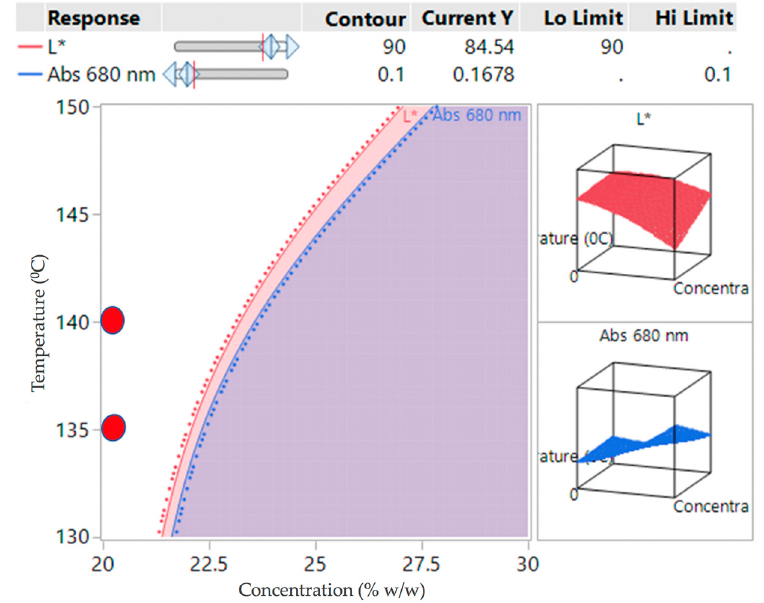
Figure 8. Contour plot for DoE2 indicating a potential design space (white region) overlaid verification study conditions (red circles).